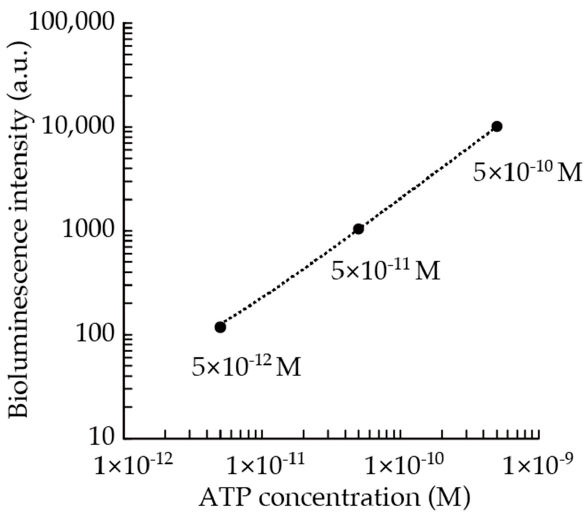
Figure 7. Relationship between ATP concentration and bioluminescence intensity measured by the in-situ ATP analyzer in the laboratory environment. Continuous data for 10 s at each ATP concentration were integrated, the blank value was subtracted and plotted with the ATP concentration.